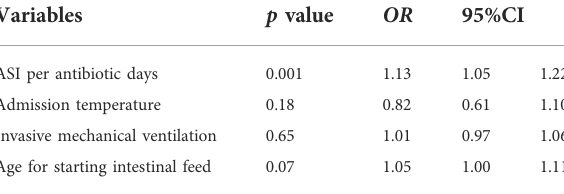
TABLE 4 Conditional Logistics regression analysis of NEC risk